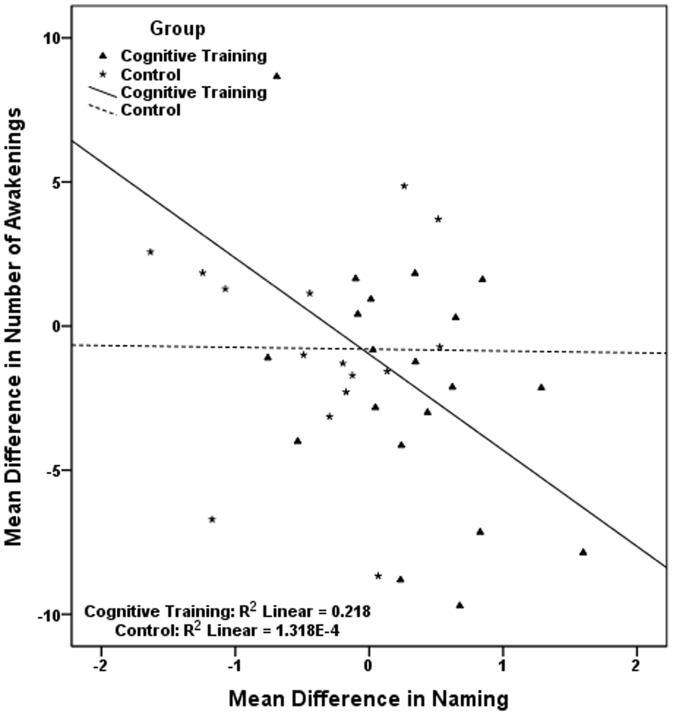
Linear regression between Mean Difference (post-intervention mean minus baseline mean) in Number of Awakening (dependent) and Mean Difference (post-intervention mean minus baseline mean) in Naming (independent).